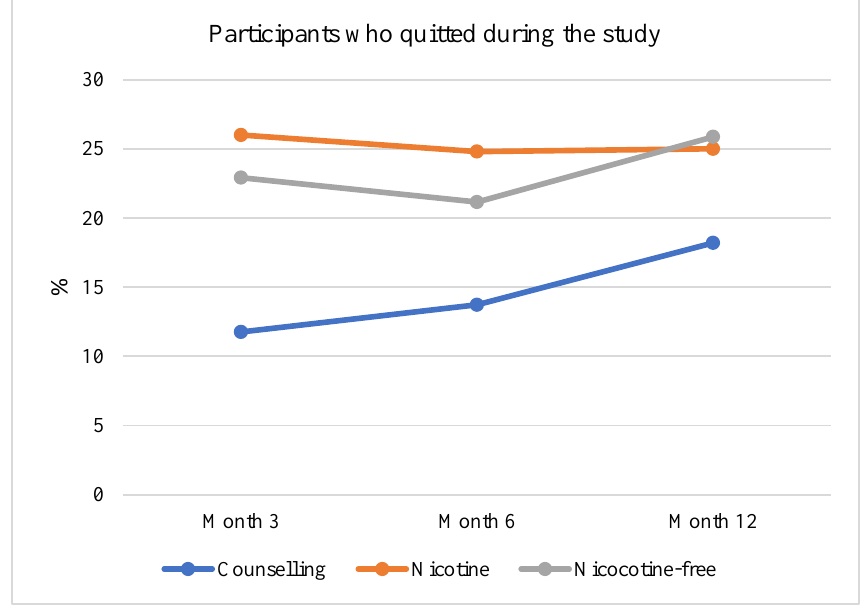
Figure 4. Percentage of quitters during the study by arm